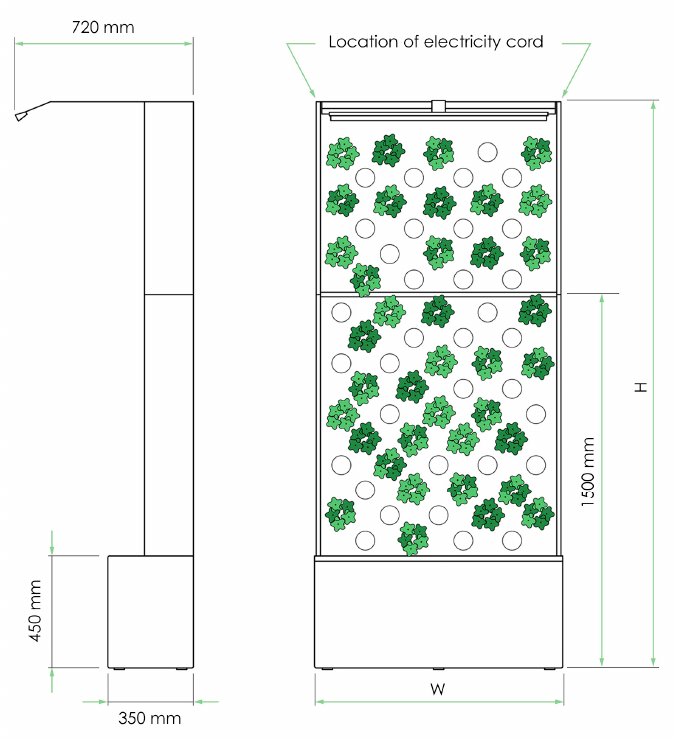
Figure 9. Smart living wall based on [35].